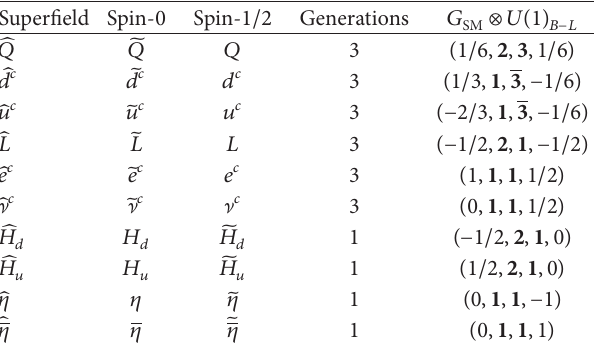
Table 1: Chiral superfields and their quantum numbers under 𝐺 𝑈( 1